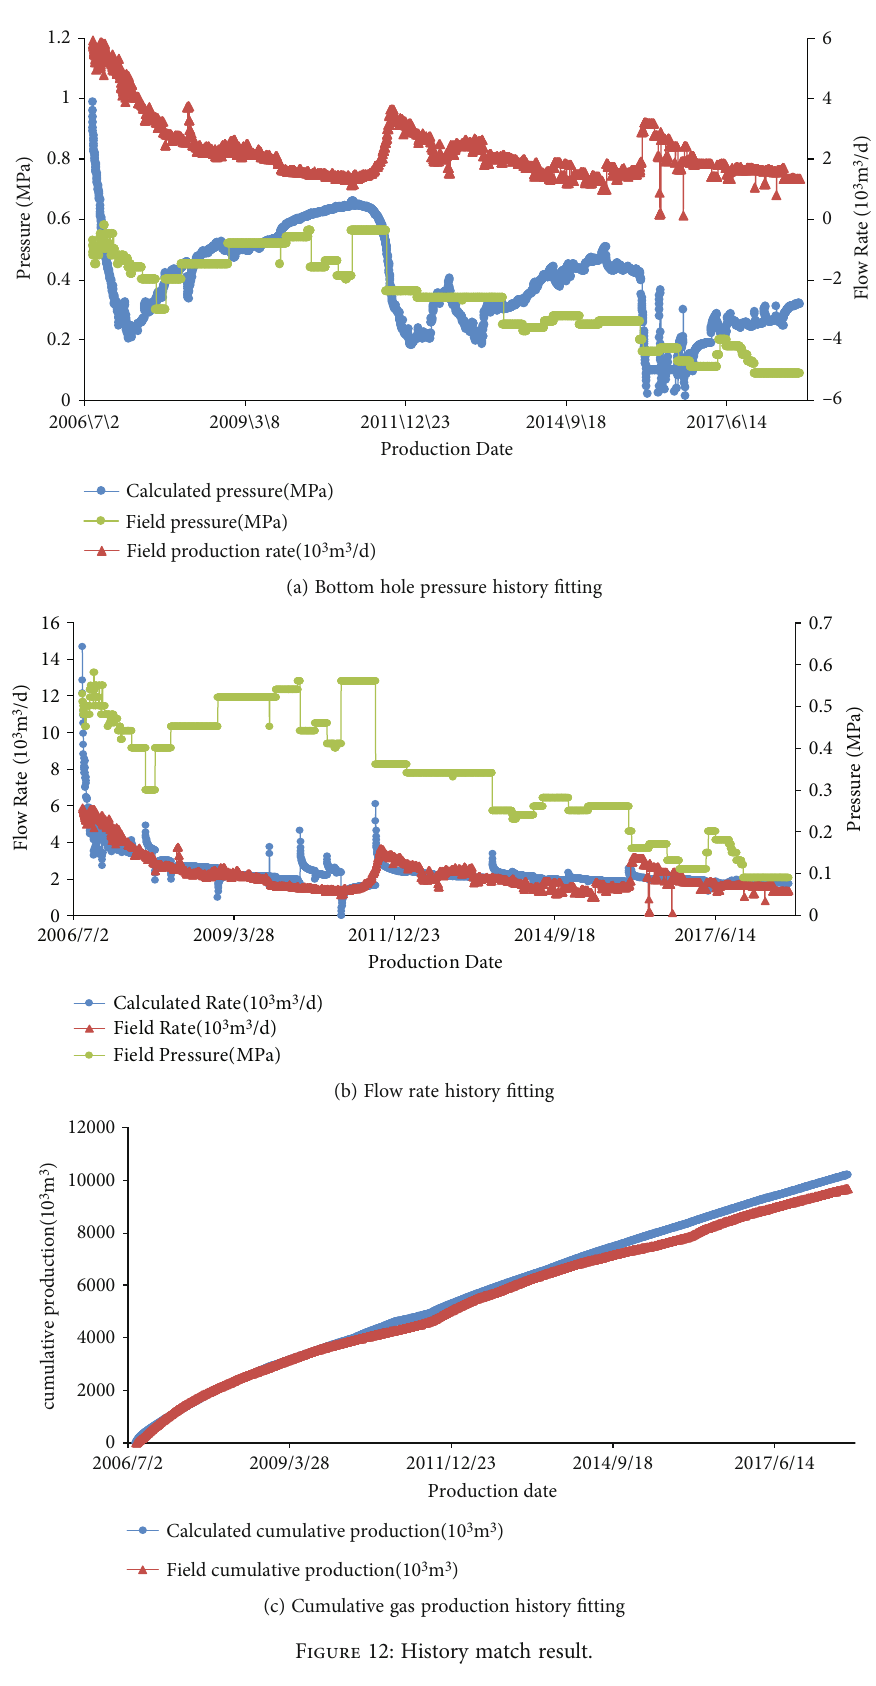
Figure 12: History match